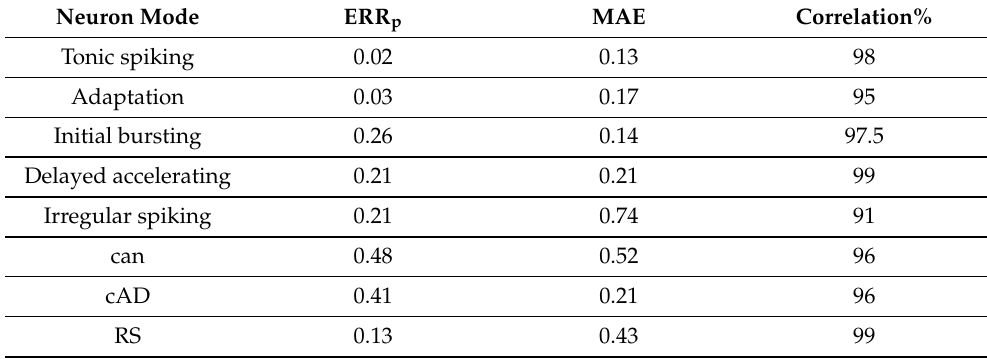
Table 2. ERR p , MAE and correlation computations for different spiking